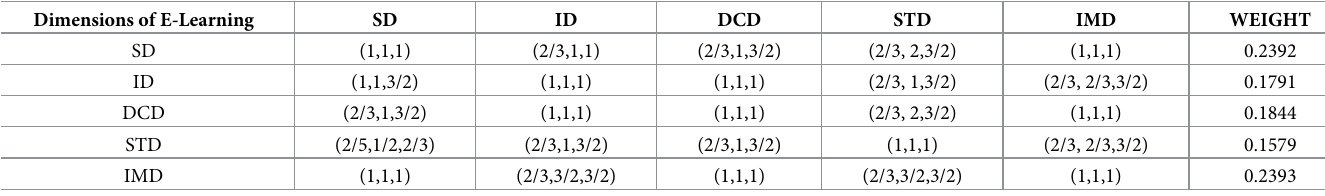
Table 11. A pairwise comparison of E-Learning dimensions using FAHP. Dimensions of E-Learning